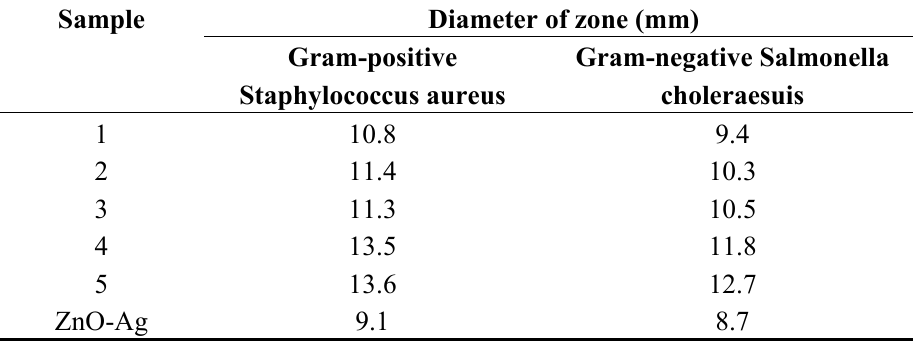
Table 1. Inhibition zone of ZnO-Ag/CNCs and ZnO-Ag